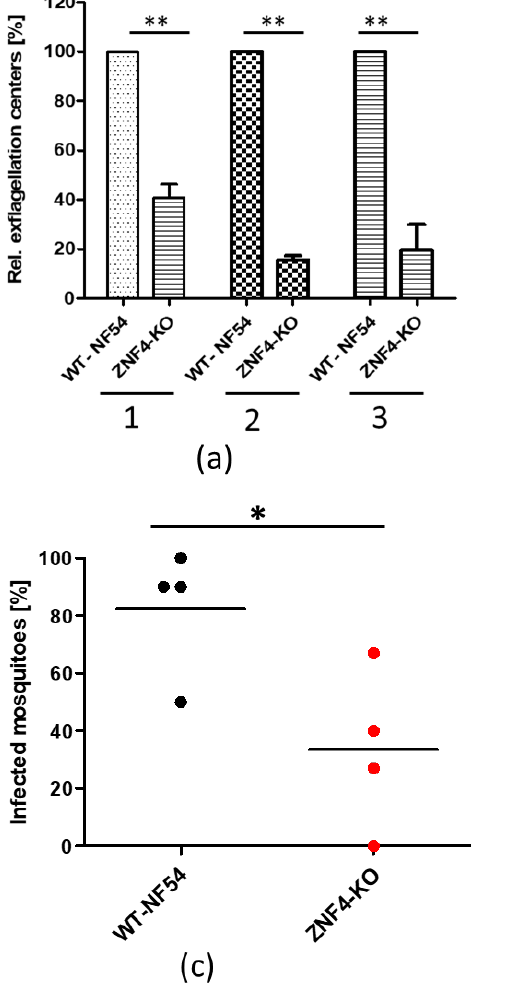
Figure 3. ZNF4-KO impairs male gametocyte exflagellation and parasite transmission in the mosquito: ( a ) Disruption of ZNF4 impairs male gametocyte exflagellation. Mature WT and ZNF4-KO game- tocytes were activated in vitro and the number of exflagellation centres was counted in 30 fields in triplicate using the light microscope. Three independent experiments were performed, indicated in numbers 1 to 3. **, p < 0.01, Student’s t test. ( b ) Mosquito infectivity of ZNF4-KO. Enriched mature gametocytes of WT or the ZNF4-KO were fed to An. stephensi mosquitoes via standard membrane feeding assays. The number of oocysts per midgut were counted at day 7 post-infection in four independent experiments; ***, p < 0.001, **, p < 0.01; ns, not significant, Student’s t test. ( c ) Percentage of infected mosquitoes in WT versus ZNF4-KO in each standard membrane-feeding experiment; * p < 0.05, Student ’ s t test.